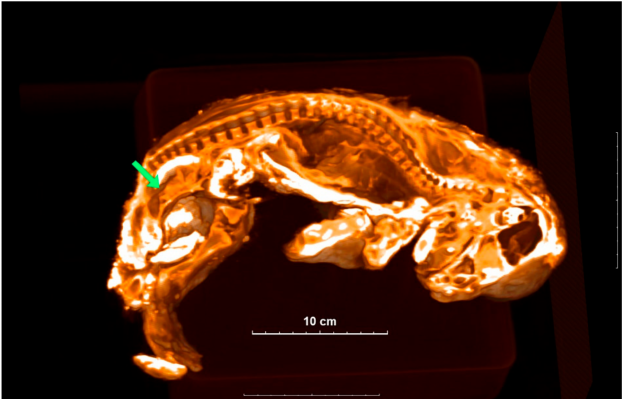
Figure 2. A 3D image of Sparta is sectioned to show the inside structure. Green arrow shows the location of the uterus-like organ.